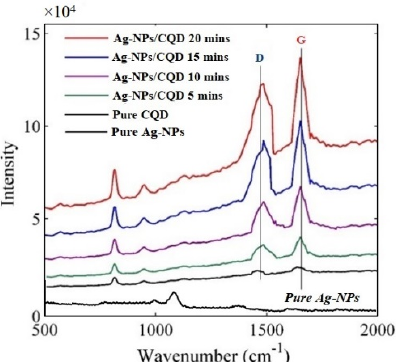
Figure 9. Raman shift spectrum for pure Au–NPs in water at 20 min, a pure CD solution, Ag–NPs/CD 5 min, 10 min, 15 min and 20 min composite solutions.